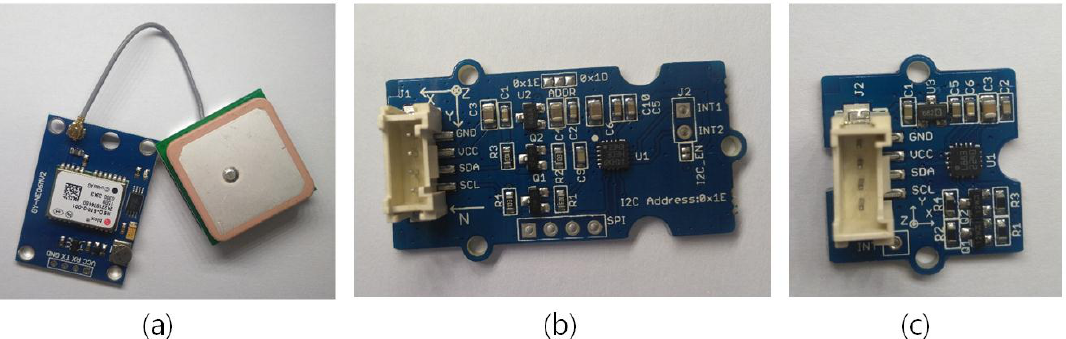
Figure 3. Location-tracking sensors: ( a ) global positioning system (GPS) module; ( b ) 6-axis accelerometer and compass; ( c ) digital compass.